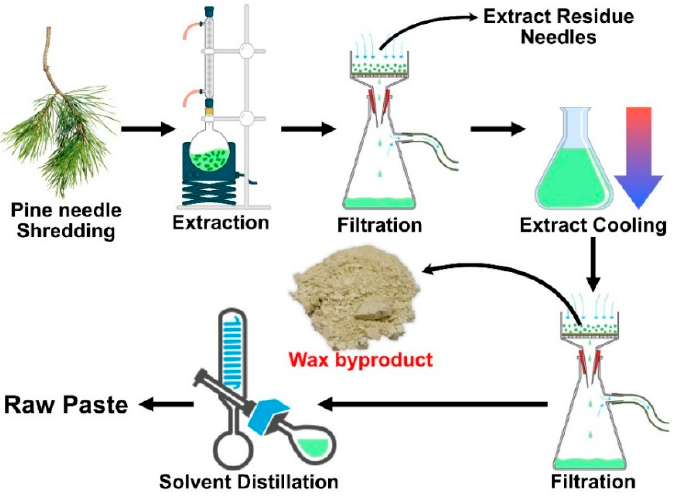
Figure 1. Schematic representation of pine needle extraction process.